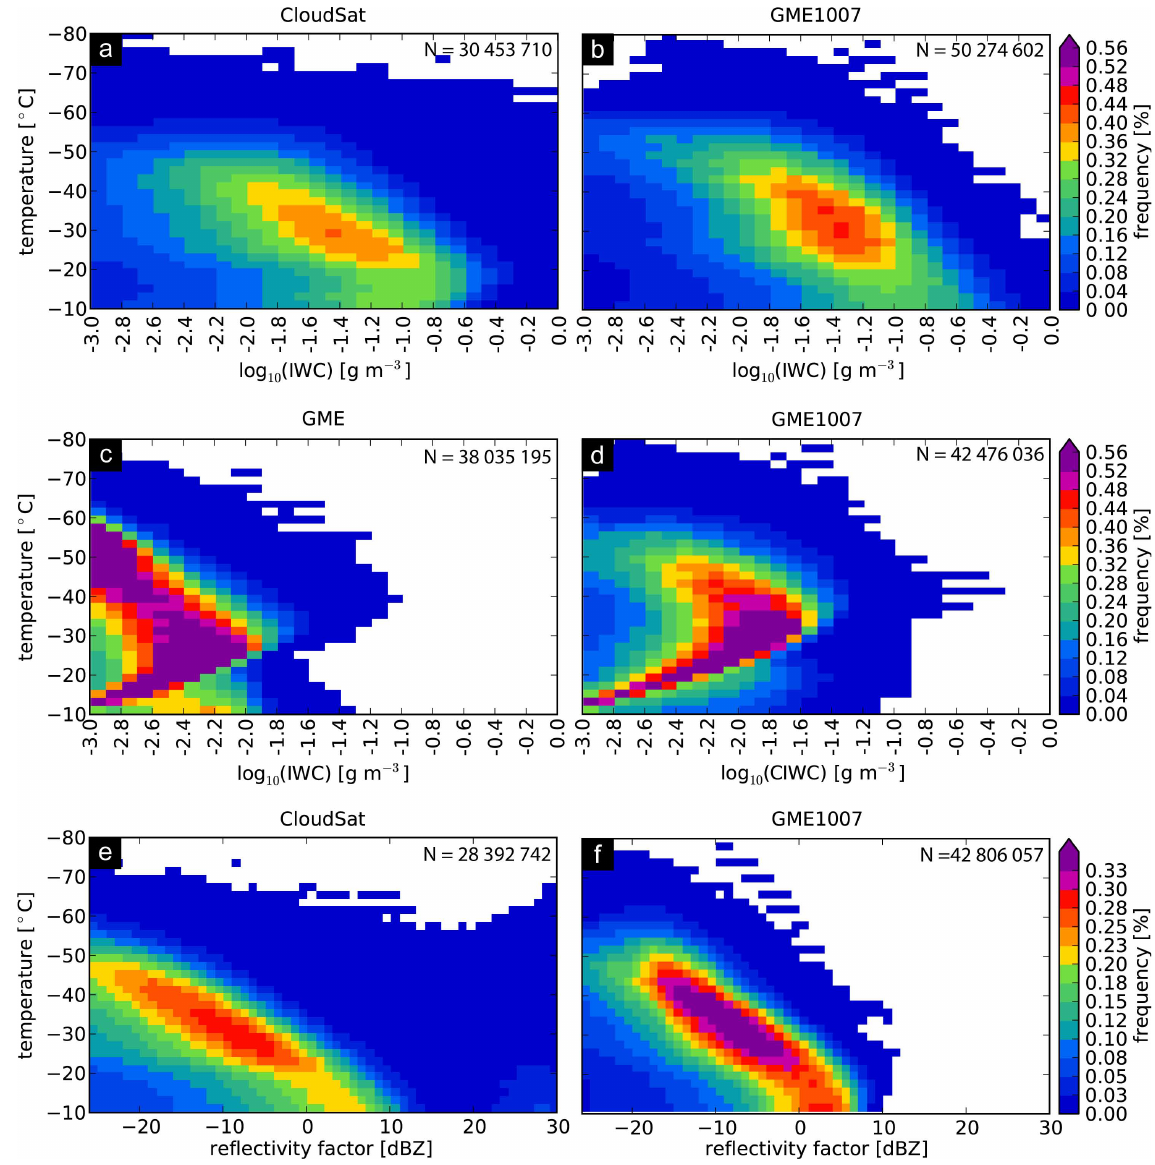
Fig. 3. Frequency distributions for 1 July 2009 to 31 October 2009. (a) CloudSat IWC, (b) GME1007 IWC, (c) GME IWC, (d) GME1007 CIWC, (e) CloudSat reflectivity factor, and (f) GME1007 reflectivity factor. Each data set is normalized with its number N of included